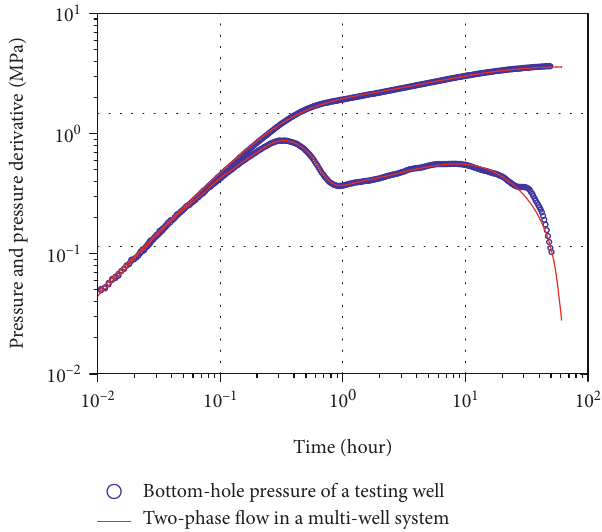
Figure 19: History matching results computed by our